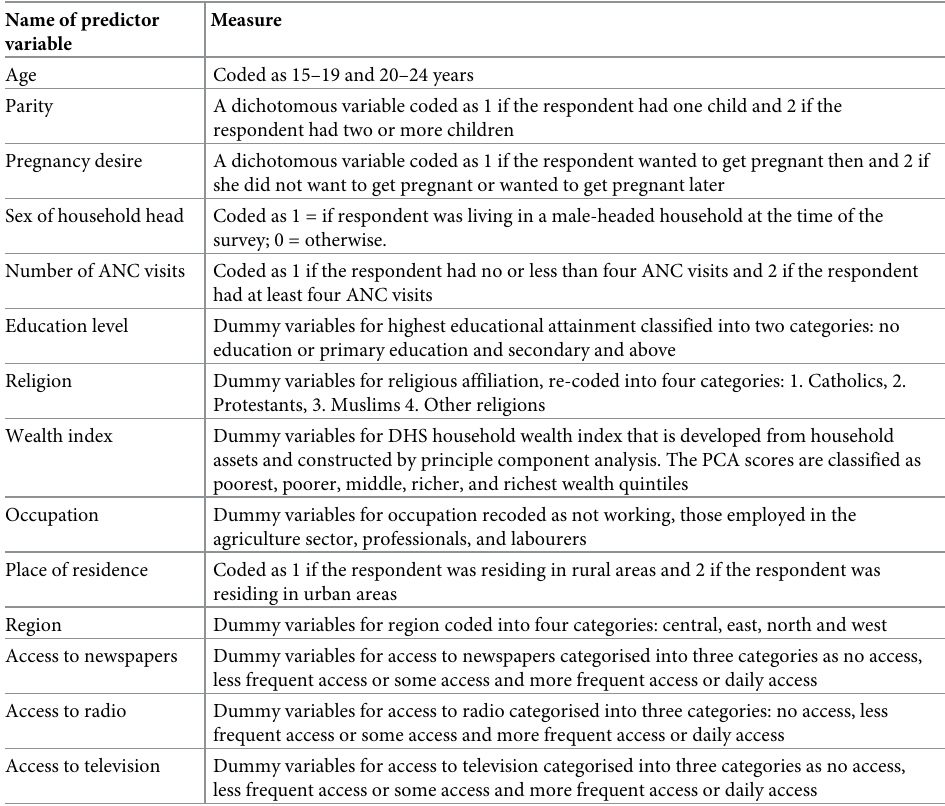
Table 1. Description of predictor